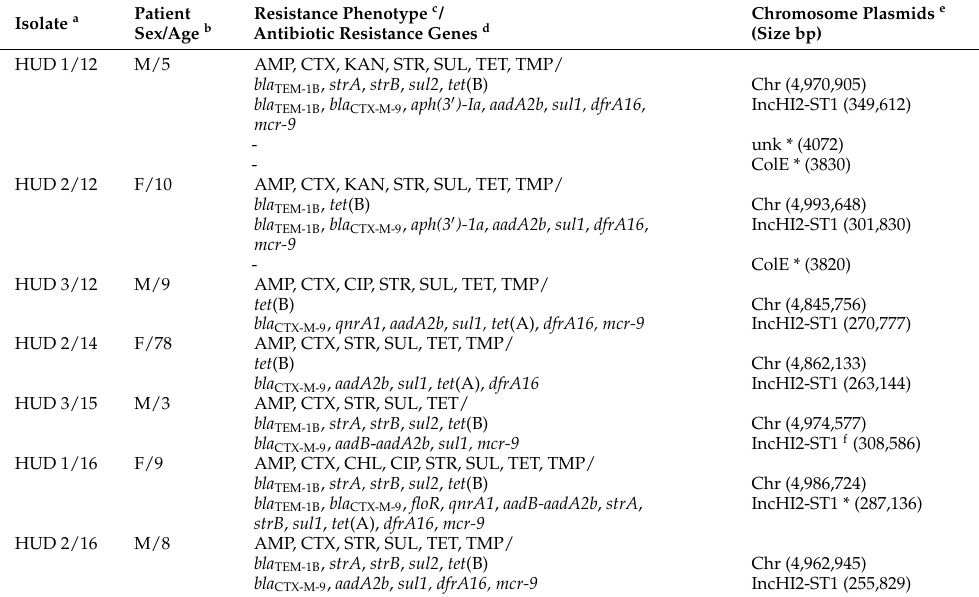
Table 1. Origin, resistance phenotype and genetic basis of antibiotic resistance in monophasic S . Typhimurium ST34 isolates from a Spanish